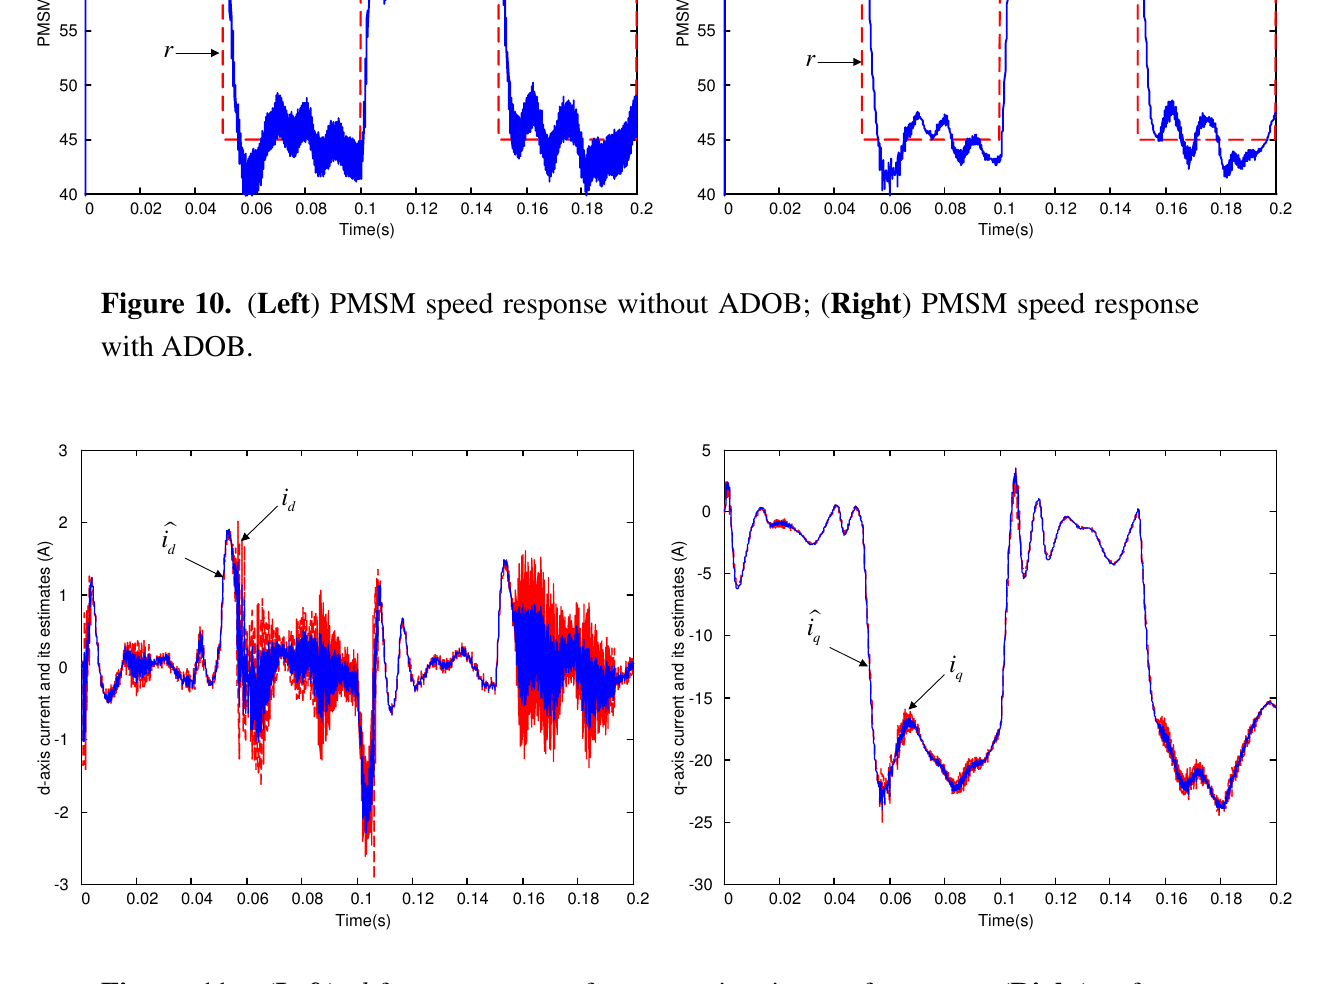
Figure 11. ( Left ) d -frame current reference estimation performance; ( Right ) q -frame current reference estimation